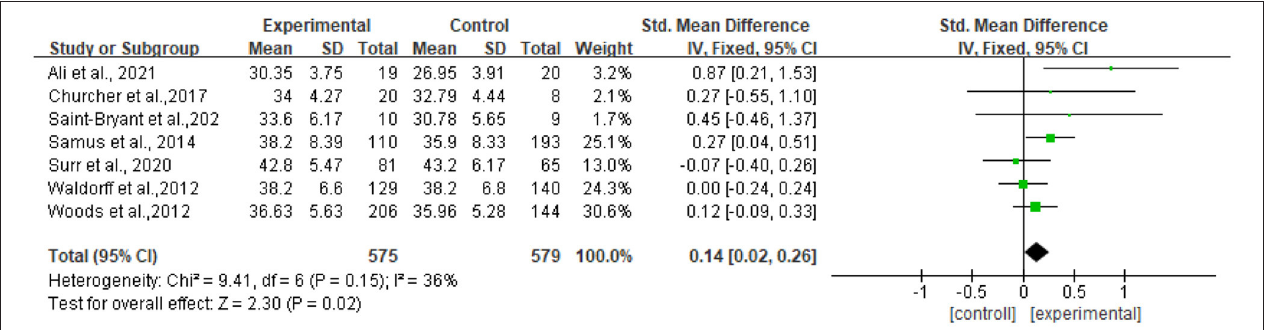
FIGURE 3 | Effect size of the intervention group vs. the control group on QOL-AD rating